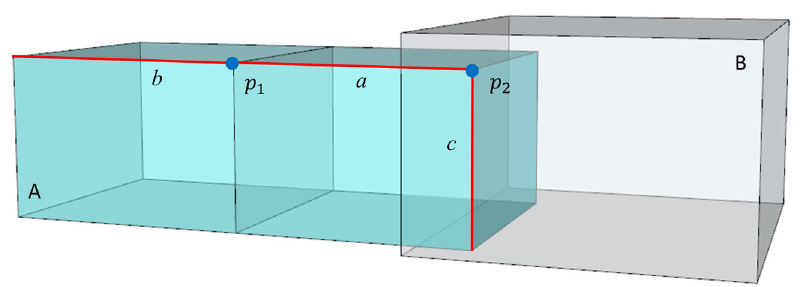
Figure 5. Boundary vertices of building models (A,B) (different colors represent different components; b and c are the ordinary edge; a is the boundary edge; p 1 and p 2 are ordinary and boundary vertices, respectively).